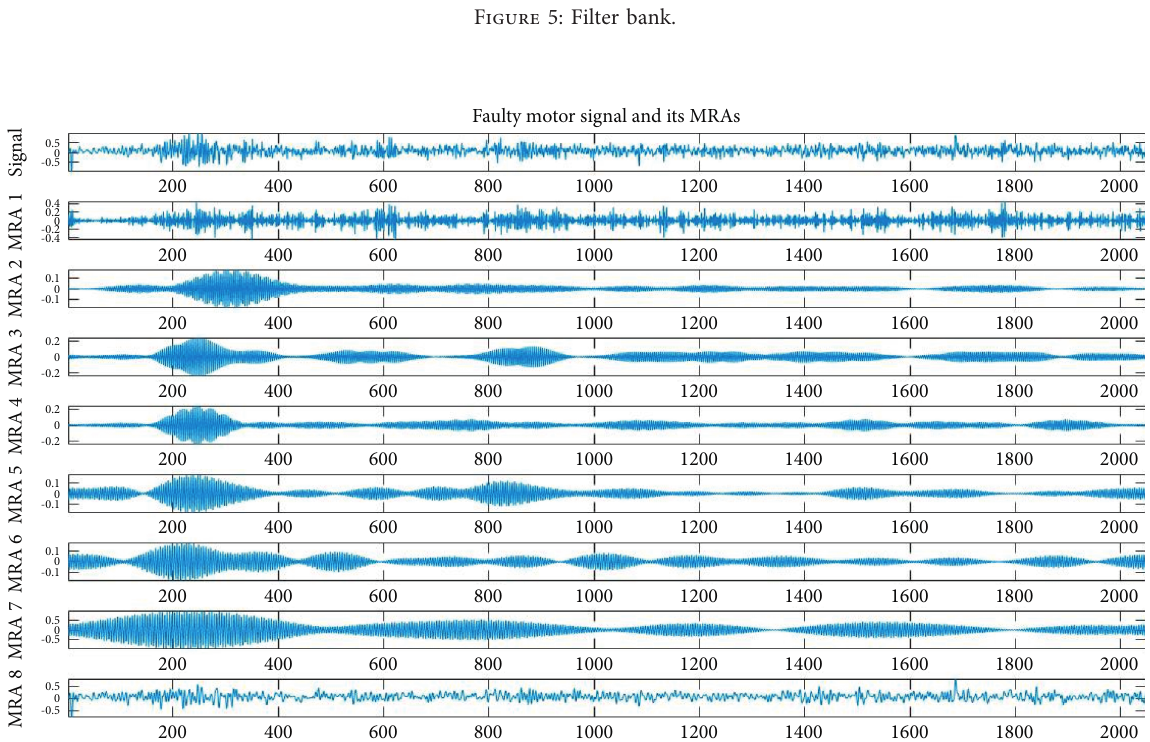
Figure 6: Faulty motor signal and its MRAs.